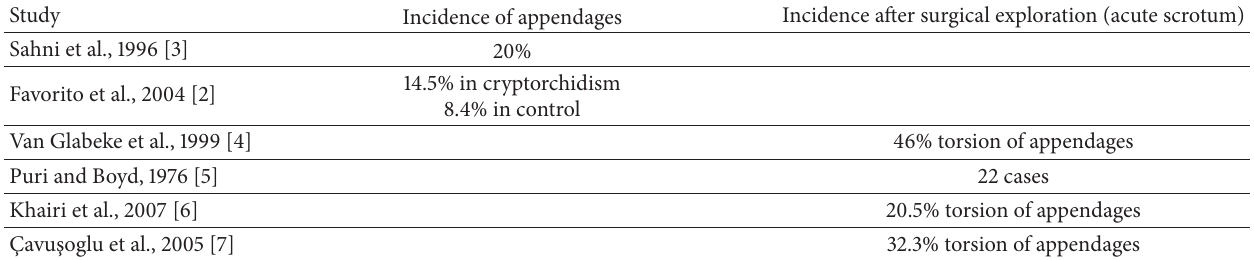
Table 1: Summary of studies describing testicular and epididymal